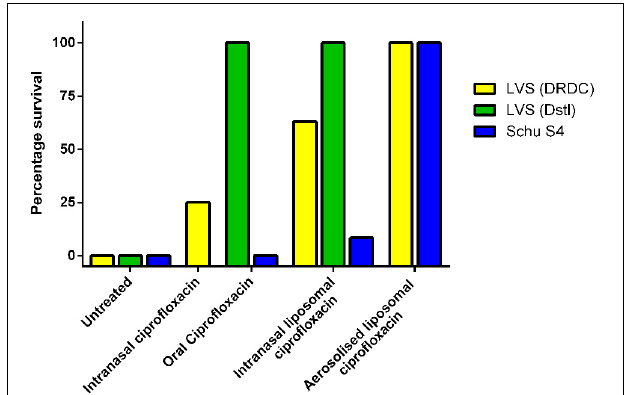
FIGURE 1 | Therapeutic efficacy of a single dose of ciprofloxacin or liposomal ciprofloxacin against murine inhalational F. tularensis LVS and Schu S4 infection. Mice were challenged with F. tularensis LVS by the intranasal route (approximately 1 × 10 2 CFU at DRDC or 6 × 10 4 CFU at Dstl) or F. tularensis Schu S4 by the aerosol route (10 CFU retained dose). Treatment was initiated at 72h post-challenge for LVS infections and 24h post-challenge in the Schu S4 study. Treatment included 50mg/kg of oral ciprofloxacin, 50mg/kg of intranasal ciprofloxacin, 50mg/kg liposomal ciprofloxacin, or 1mg/kg lung dose of aerosolized liposomal ciprofloxacin. Graph shows percentage survival at the end of the experiment. LVS (DRDC) data is adapted from Di Ninno et al. (1993) (Intranasal ciprofloxacin and liposomal ciprofloxacin) and Wong et al. (2003) (aerosolized liposomal ciprofloxacin). Schu S4 and LVS (Dstl) data is adapted from Hamblin et al.